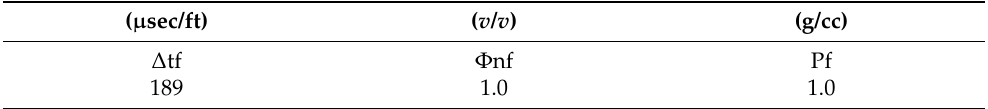
Table 1. Parameters used for MN